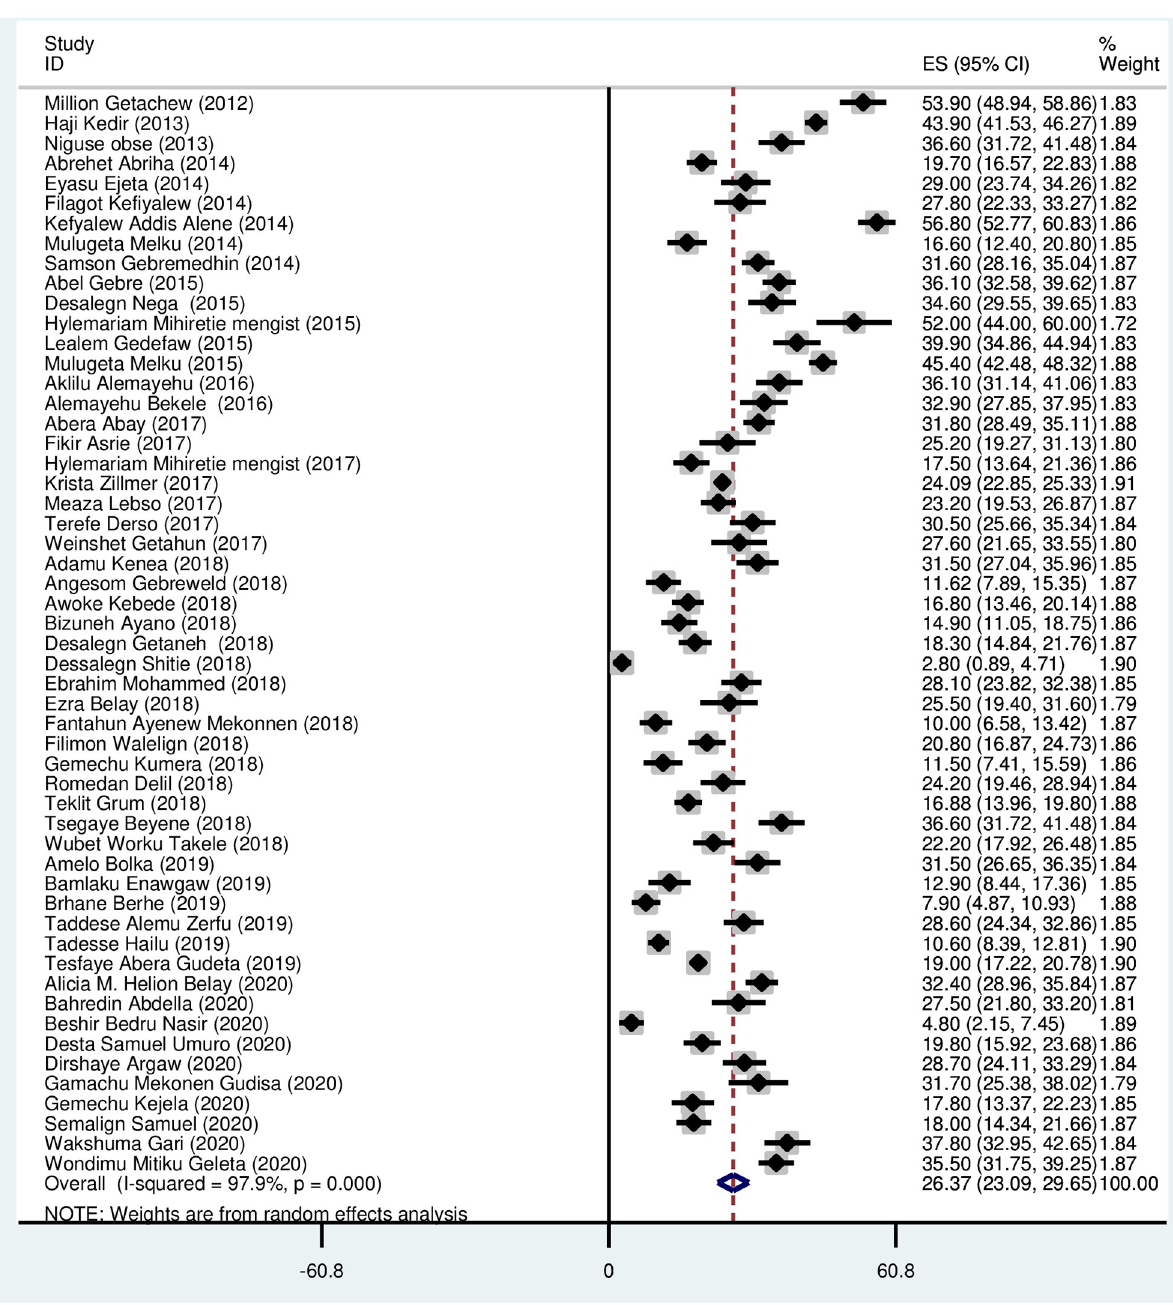
medium and high dietary diversity. The heterogeneity test showed statistically significant het- erogeneity (I 2 = 94.5, p < 0.001) (Fig 4). In testing for publication bias, the Begg’s and Egger’s tests showed no statistically significant evidence of small study effect, p = 0.107 and 0.060 respectively.